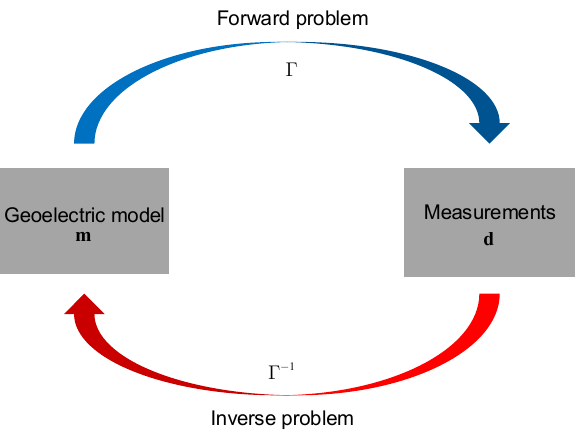
Figure 1. High-level illustration of the forward and inverse problems.